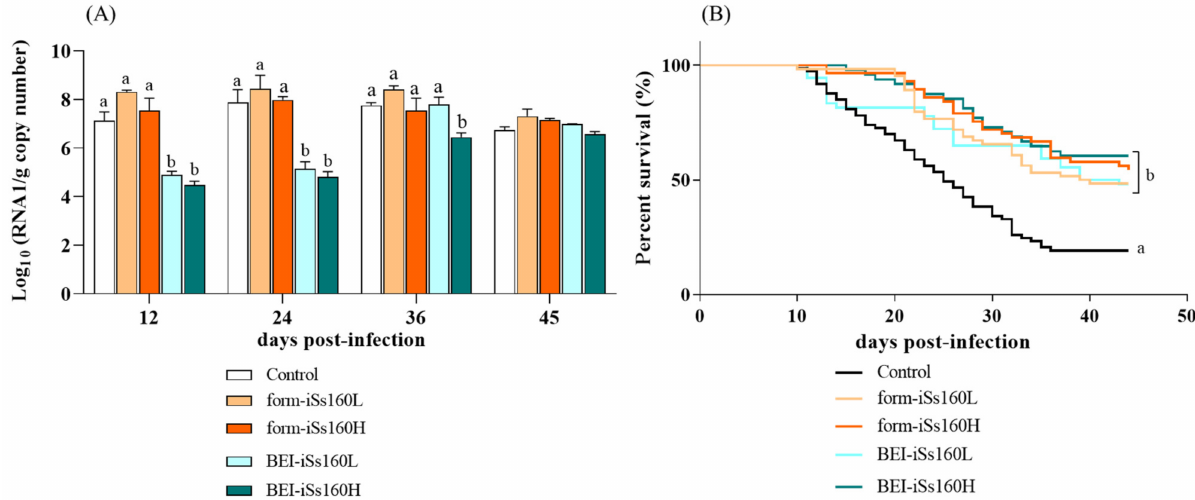
Figure 4. All vaccines induce partial protection and BEI-iSs160 decreases the viral load after challenge. ( A ) viral load (n = 3 fish/group and time) in brain and ( B ) Percent of survival during 45 days of in vivo infection in intraperitoneally vaccinated Senegalese sole specimens vaccinated with low and high dosages (10 5 and 10 7 TCID 50 /mL, iSs160L and iSs160H, respectively) of BEI-iSs160 vaccine (inactivated with BEI) and form-iSs160 (formalin inactivated) or PBS (Control). Infection was performed by 3 h of immersion with 10 7 TCID 50 /mL. Survival rates were compared between groups using Kaplan Meier test. Lower letters denote statistical differences between groups of the same time point according to the two-way ANOVA test ( p <